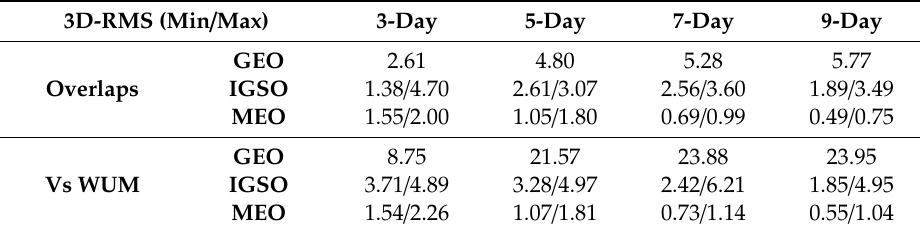
Table 5. The minimum and maximum values of 3D-RMS for BDS satellites (Unit: m).